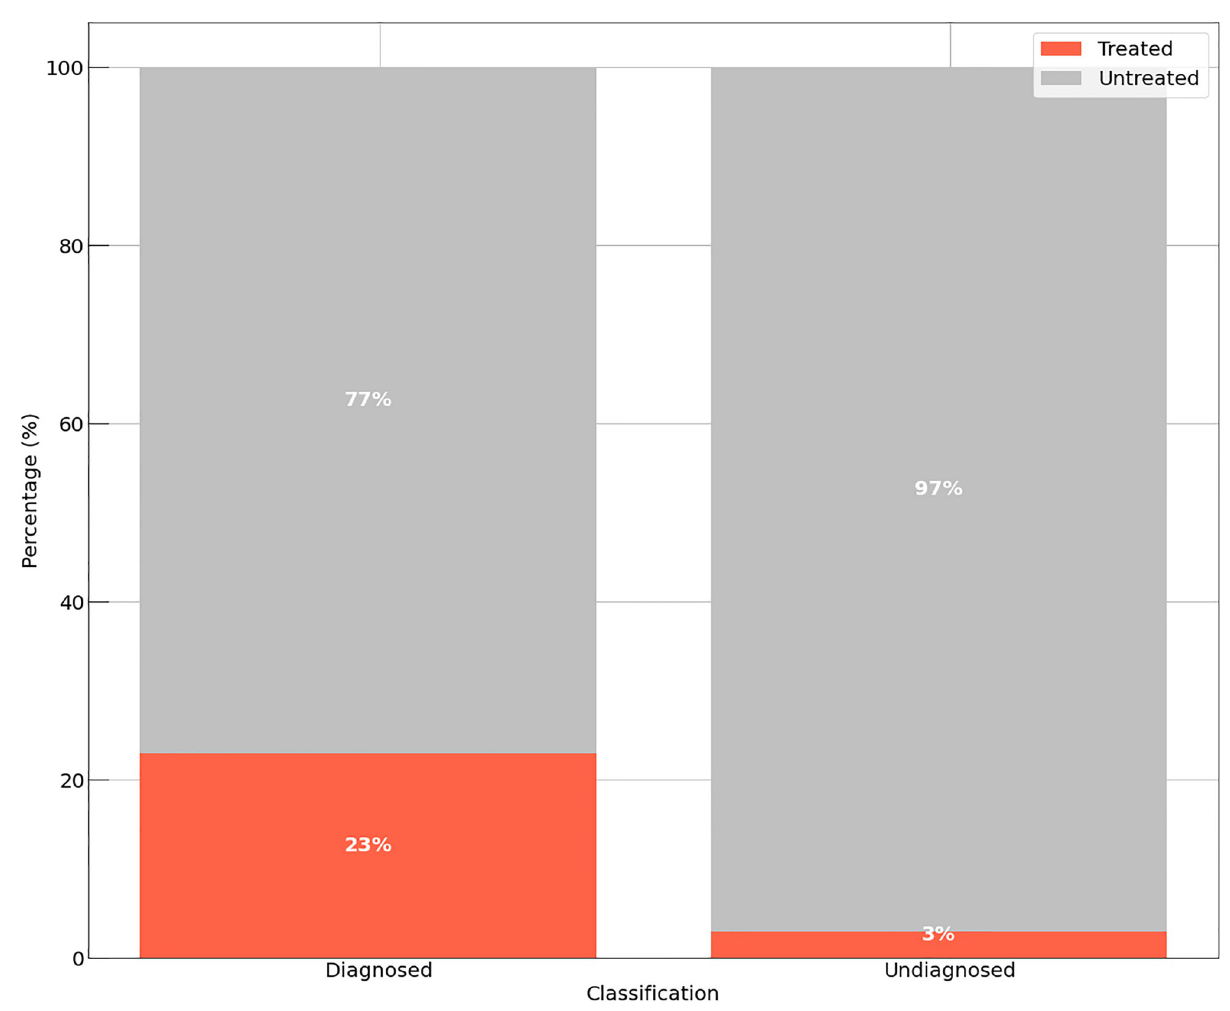
Fig 5. Quantitative of patients. The figure shows the percentages of diagnoses by individuals.